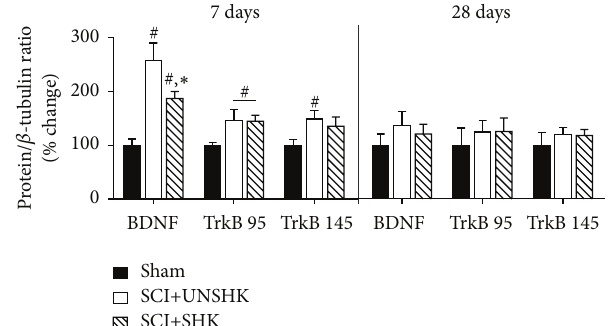
Figure 6: BDNF and TrkB expression in the dorsal spinal cord after SCI: Western blot was used to assess BDNF, TrkB 95 and TrkB 145 expression at 7 and 28 days after SCI in adult rats. Noxious tailshock was given 24 hours after SCI (SCI+SHK) to some animals. At 7 days after SCI, there was a significant increase in BDNF levels in the dorsal spinal cord of SCI animals that did not receive tailshock (SCI+UNSHK) and in SCI+SHK animals compared to sham con- trols. Although SCI+SHK animals had elevated levels of BDNF, shock treatment significantly decreased BDNF levels compared to SCI+UNSHK ( # 𝑝 < 0.05 indicates significance relative to sham and ∗ 𝑝 < 0.05 indicates significance relative to SCI+UNSHK). Both SCI groups had elevated levels of TrkB 95 in the dorsal spinal cord compared to sham control, whereas TrkB 145 was only significantly increased in the SCI+UNSHK group of animals. At 28 days after injury, there were no differences in BDNF, TrkB 95 , and TrkB 145 expression in the dorsal spinal cord among the three experimental